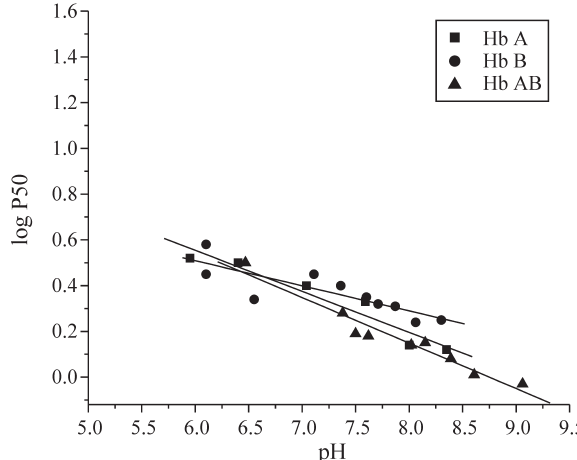
Figure 5 - pH dependence of P50 in stripped hemoglobin in the absence of the chloride ion. Buffer Hepes-Tris 0.1 M. Showing regression lines in each phenotype.